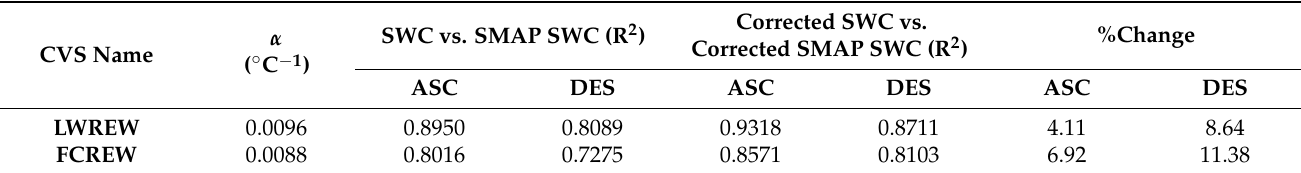
Figure 8. The relationship between two pairs of factors, ( a ) SWC and SMAP SWC and ( b ) corrected SWC and corrected SMAP SWC, at both the ascending and the descending nodes at LWREW from November 2017 to December 2019. In the figure, the suffixes “corr” stand for the terms “corrected”. Table 3. The changes in the relationship between satellite and in situ data after applying the temperature effects removal